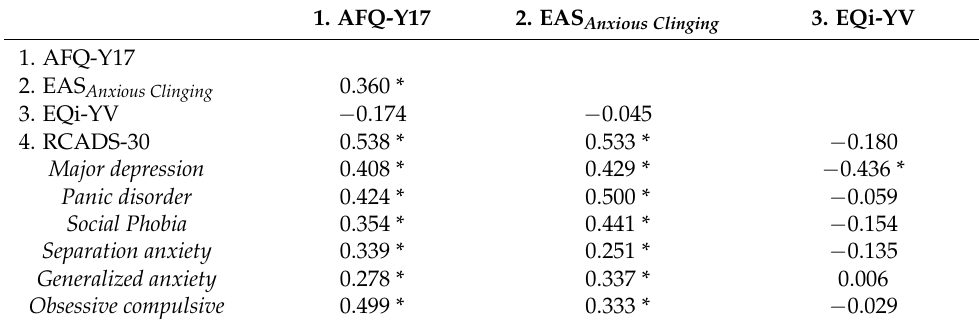
Table 5. Correlations amongst psychological inflexibility, anxious clinging, emotional intelligence and mental health symptoms (N =